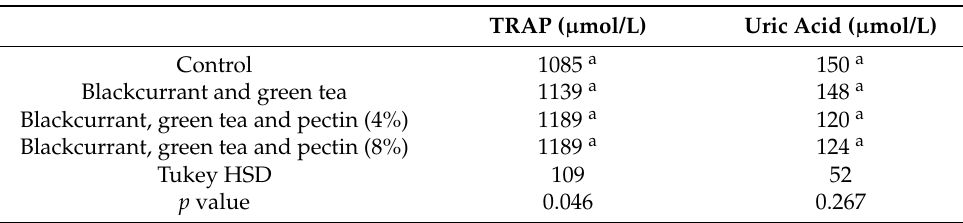
Table 6. Total peroxyl radical-trapping antioxidant parameter (TRAP) and uric acid concentrations in the plasma of rats. TRAP ( µ mol/L) Uric Acid ( µ mol/L) Control 1085 a 150 a Blackcurrant and green tea 1139 a 148 a Blackcurrant, green tea and pectin (4%) 1189 a 120 a Blackcurrant, green tea and pectin (8%) 1189 a 124 a Tukey HSD 109 52 p value 0.046